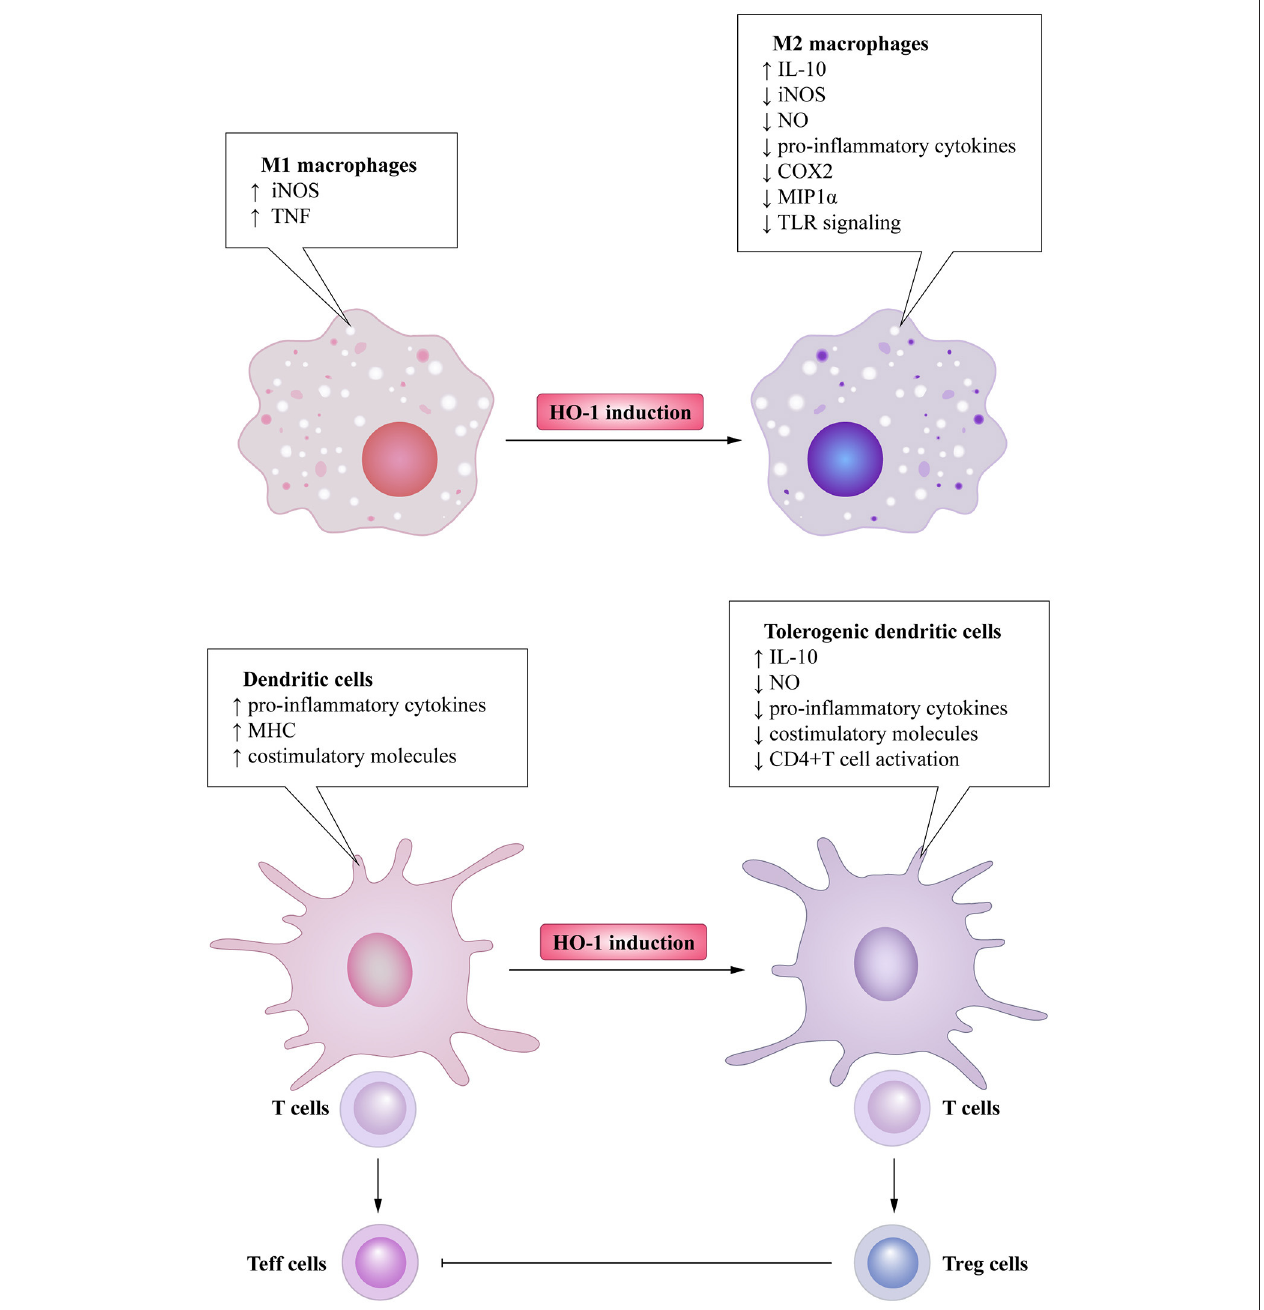
FIGURE 4 | The beneficial effect of the use of HO-1 inducers on the SLE patient. HO-1 induction in immune cells promotes polarization of macrophages into the M2 profile with anti-inflammatory property. They are capable of increasing secretion of IL-10 and decreasing secretion of pro-inflammatory cytokines and mediators. These favor the obtainment of a tolerogenic profile in DCs, thus generating regulatory T (Treg) cells differentiation, which prevents autoimmunity by inhibiting the activation and proliferation of effector T (Teff)